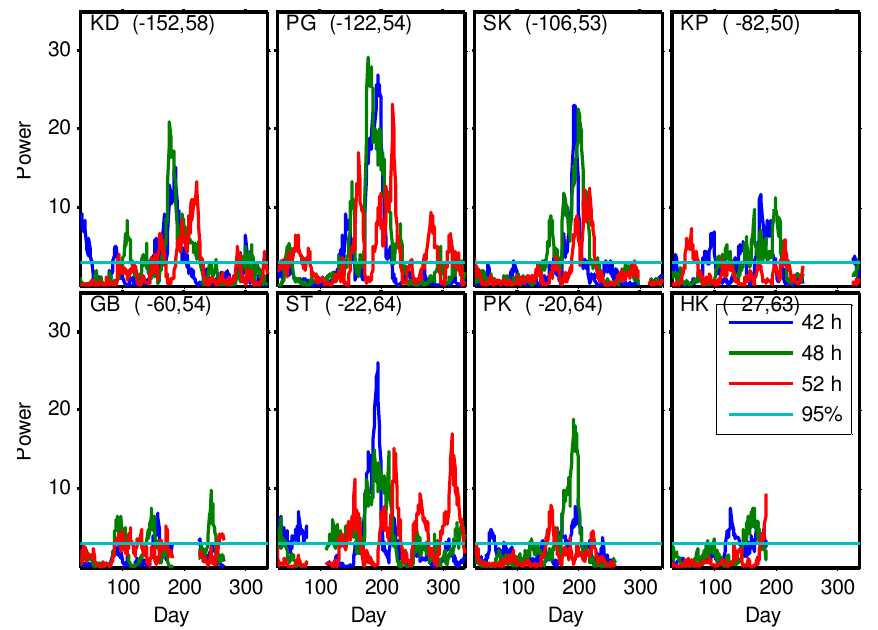
Figure 2. The normalised power spectrum for the meridional flow in summer for different radars, as indicated by the abbreviations on the top left-hand corner of each panel. The black contours represent the 95% confidence levels. ZONAL FLOW: Normalised power spectrum (28d window)